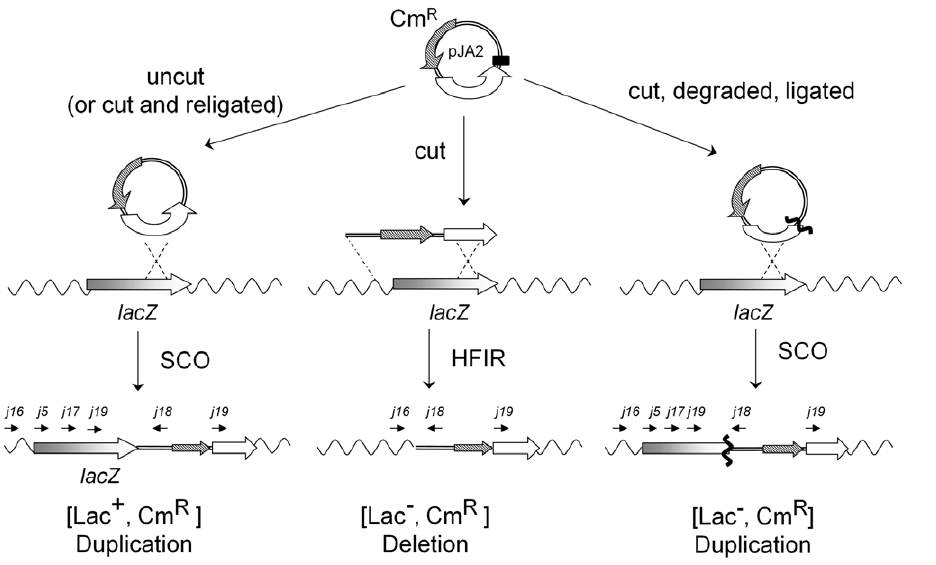
Figure 3. Inferred chromosomal recombination products obtained with plasmid pJA2. Left part : Single crossing-over (SCO) between circular pJA2 and the chromosome, as produced if pJA2 remains uncut (or if pJA2 is cut and resealed). The resulting exconjugants are Lac + Cm R . Central part : HFIR between linear pJA2 and the chromosome. Exconjugants are Lac 2 Cm R , and therefore distinguishable from the previous SCO events. Right part : If pJA2 is cut, degraded up into the lacZ sequence, and recircularized, a SCO between a circular, deleted (wavy bold line) pJA2 molecule and the chromosome will give rise to Lac 2 Cm R exconjugants. White arrow, 3 9 part of the lacZ gene. Grey box, remaining part of the lacZ gene. Wavy lines, other sequences of the E. coli chromosome. Straight line, pJA2 plasmid sequences. Black box, ‘‘cut cassette’’. Primers j18, j19, j17, j5, j16 complementary to the plasmid pJA2 and the chromosome, are shown above each chromosomal recombination product.